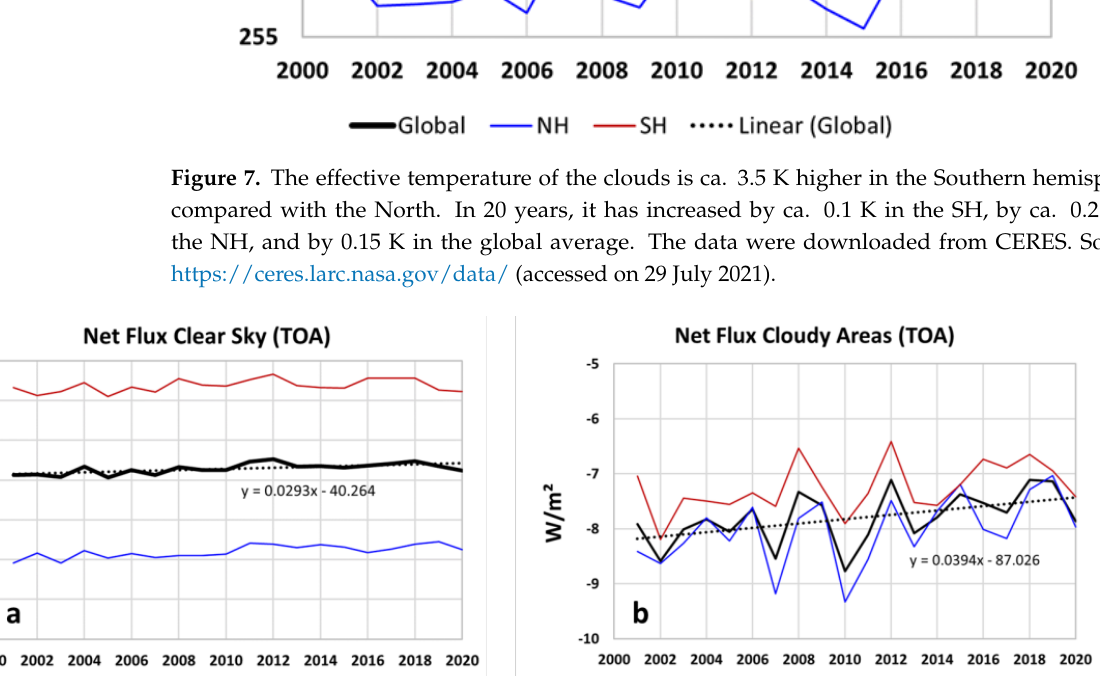
Figure 8. Net flux (TOA) over “Clear Sky” ( a ) and “Cloudy Areas” ( b ) for global average, NH, and SH. For the global values, the difference between “Clear Sky” and “Cloudy Areas” is 26 W/m 2 . This 1% change of the cloud cover corresponds to 0.26 W/m 2 flux change.